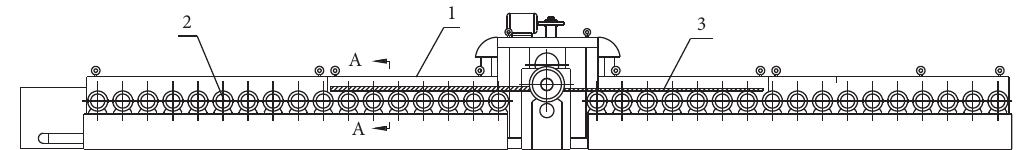
Figure 2: Positive view of the hot air edge temperature compensation roller incubator for rolling the magnesium alloy.1, roller incubator; 2, roller motor; 3, magnesium plate.